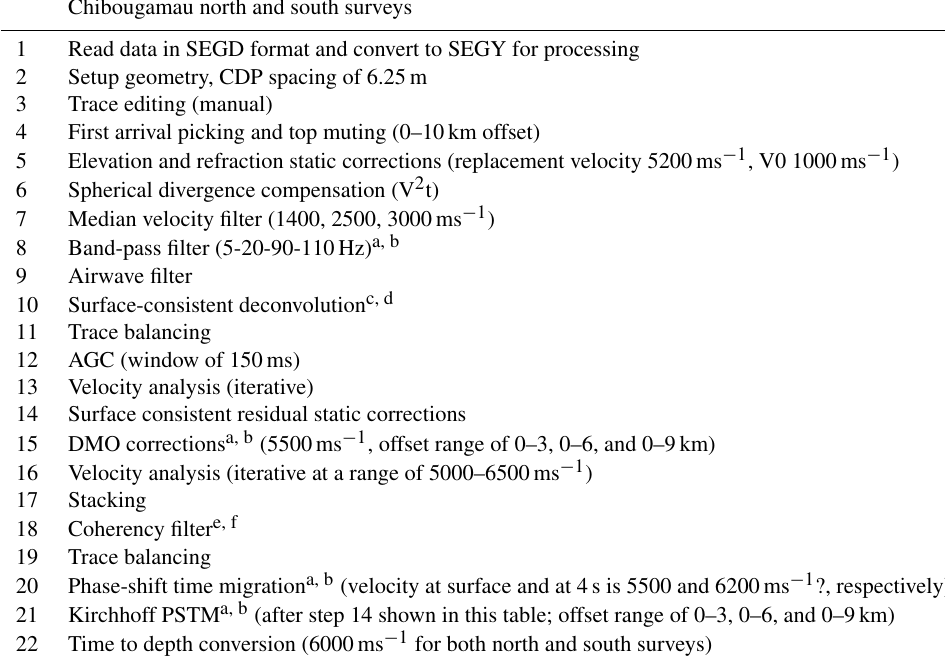
Figure 2. CMP offset and azimuth distribution from the north survey. The offset distribution is shown for (a) CDP 500, (b) CDP 1000, (c) CDP 1500, and (d) CDP 2000. See Figs. 1 and 4 for the location of the CDPs. The negative values for CMP distance in graphs (a– d) indicate CMP is located in the south of the bin center and the positive values imply that CMP is located in the north of the bin center. The azimuth distribution is shown for (e) CDP 500, (f) CDP 1000, (g) CDP 1500, and (h) CDP 2000. For each diagram shown in (e–h) the CDP line direction is presented. The CDP bin is perpendicular to the CDP line. Table 2. Processing parameters and attributes for the Chibougamau surveys. Chibougamau north and south